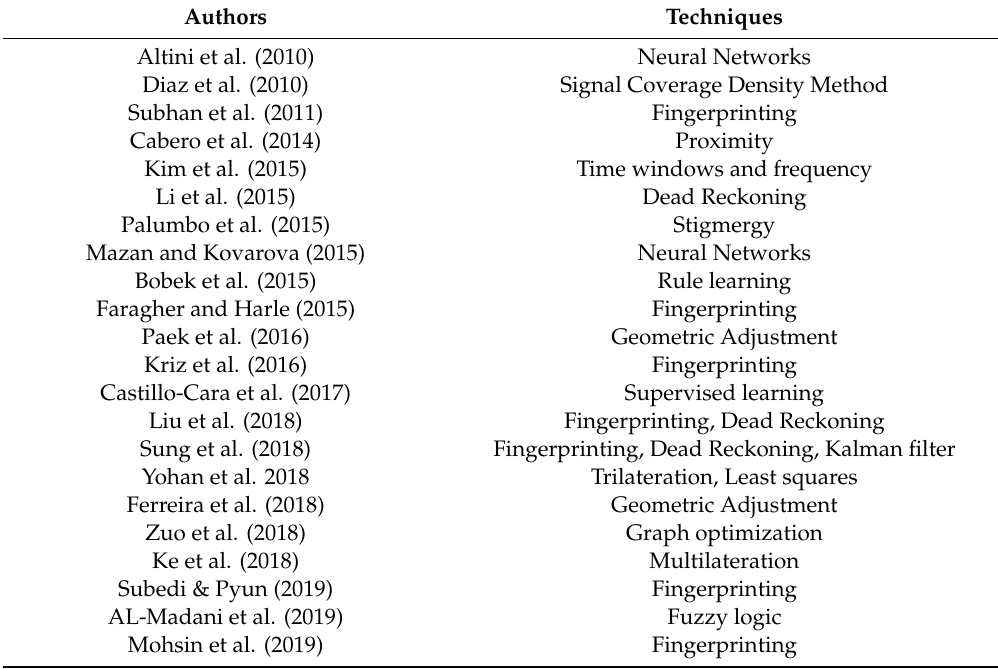
Table 3. Overview of studies that utilize Bluetooth technology for indoor positioning.